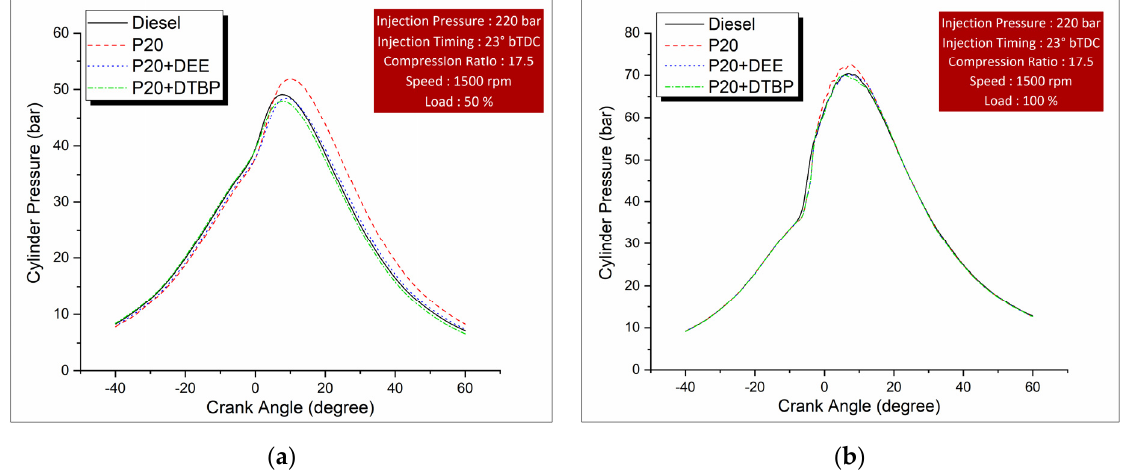
Figure 2. Cylinder pressure variation for test fuel blends, ( a ) at 50% load; ( b ) at 100%